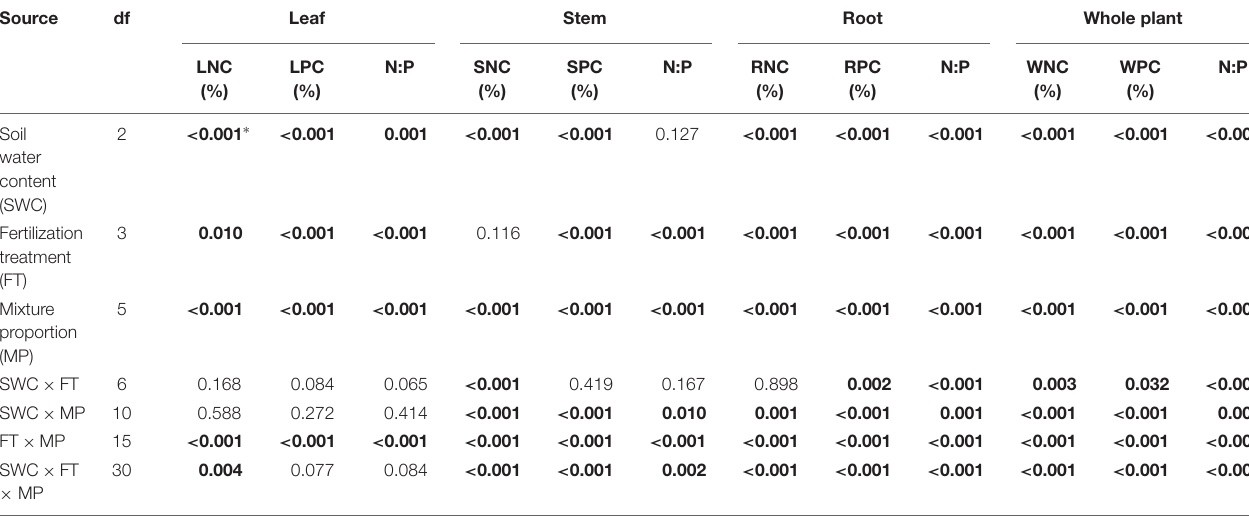
TABLE 1 | P -values of three-way ANOVA to evaluate the effect of soil water content (SWC), fertilization treatment (FT), mixture proportion (MP) and their interactions on N and P concentration in leaves, stems, roots and whole plants of Lespedeza davurica intercropped with Bothriochloa ischaemum . Source df Leaf Stem Root Whole plant